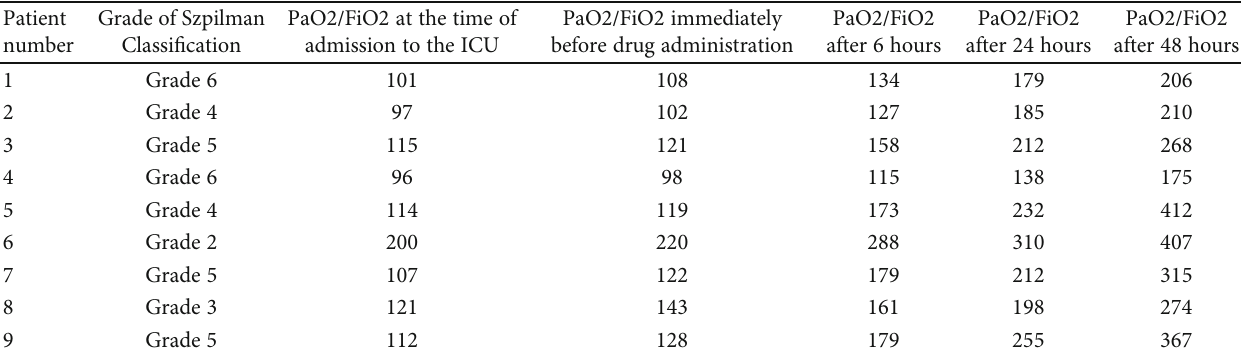
Table 2: Classi fi cation and evolution of the PaO2/FiO2